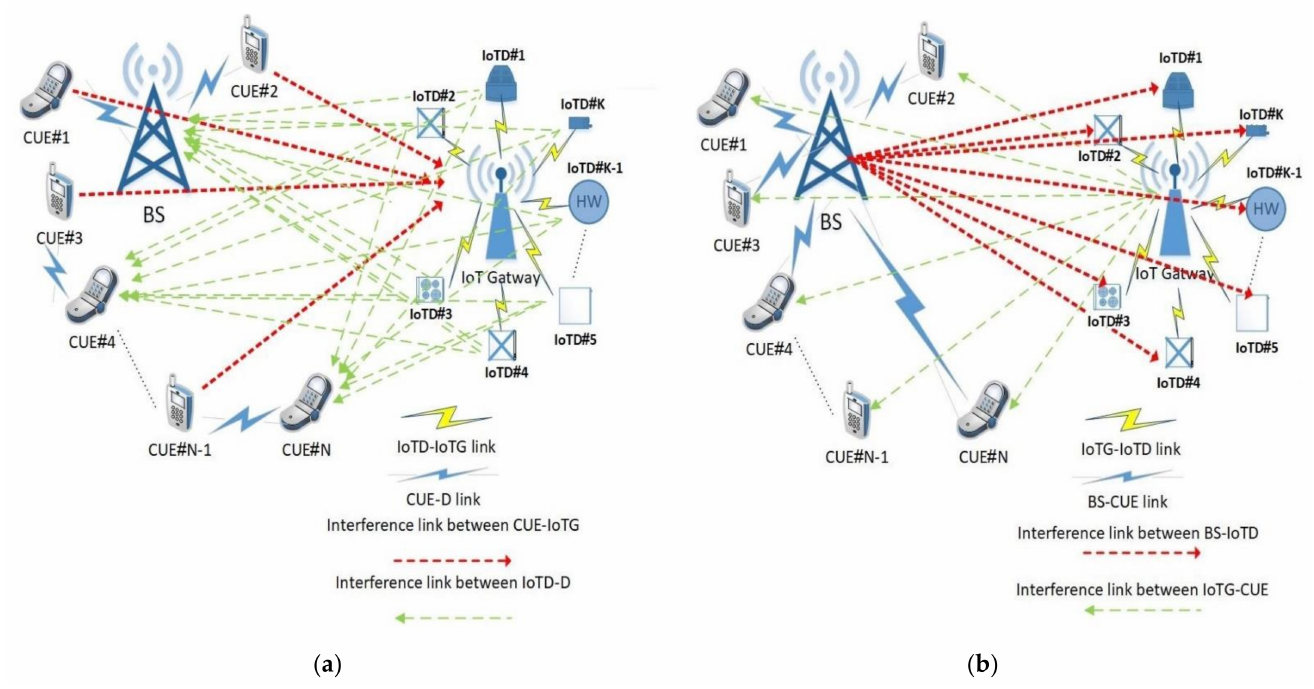
Figure 1. Proposed network schematic. ( a ) Uplink data communication ( b ) Downlink data